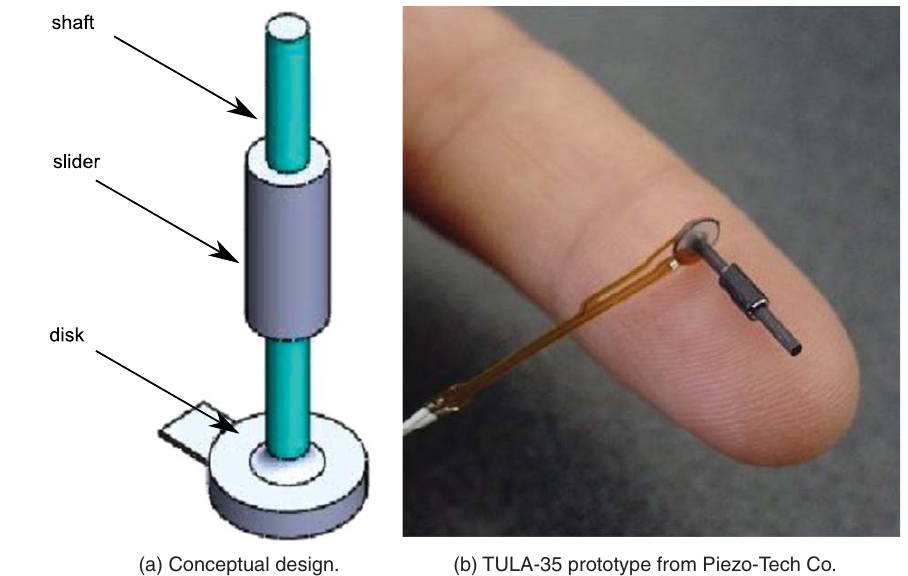
Fig. 4. Miniature piezoelectric ultrasonic linear